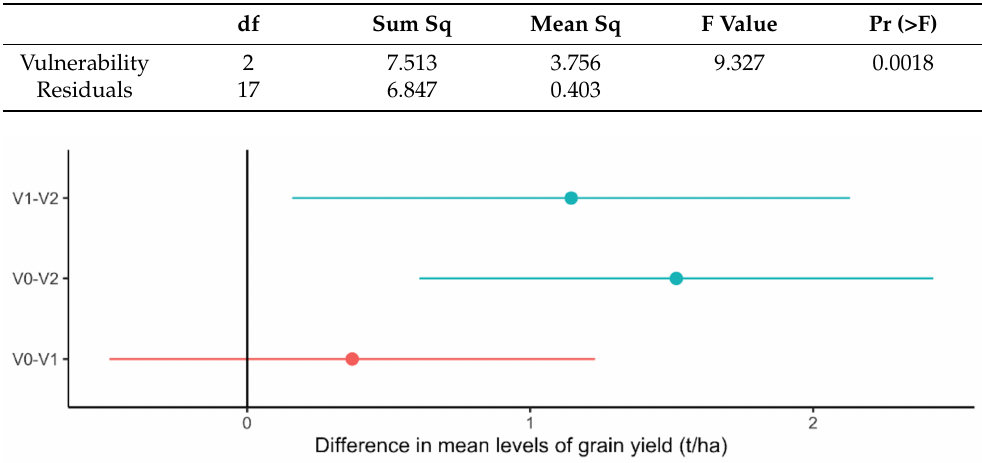
Table 7. Model 3, estimation of explanatory variables for the “Nested, only Vulnerability” optimal model. Significant explanatory variables at p < 0.01 level are shown in boldface.